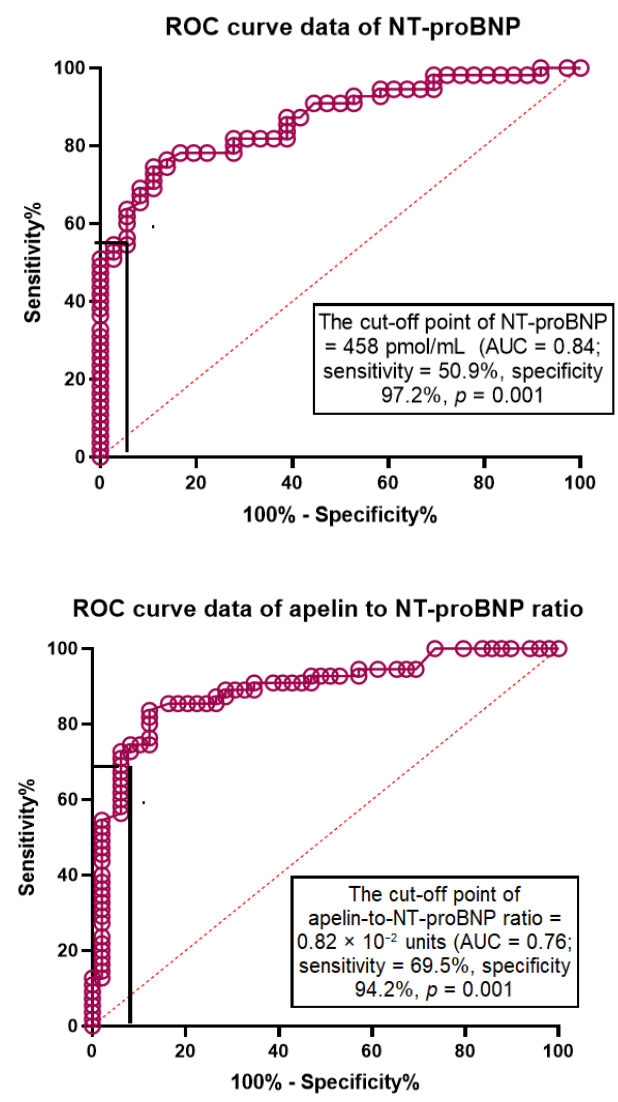
Figure 3. Apelin, NT-proBNP and Apelin to NT-proBNP ratio in prediction of HFpEF: Receiver operating characteristic curve analysis.